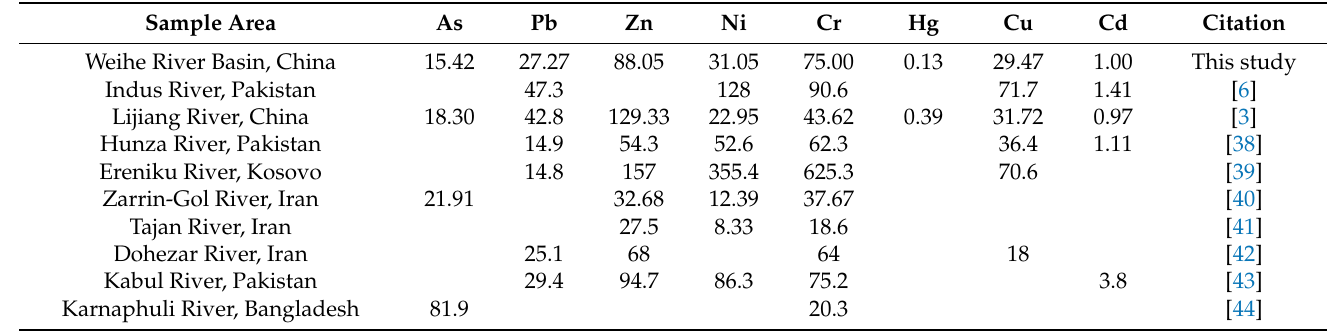
Table 8. Comparison of heavy metals concentration (mg · kg − 1 ) in sediments of the Weihe River Basin with other selected rivers in the